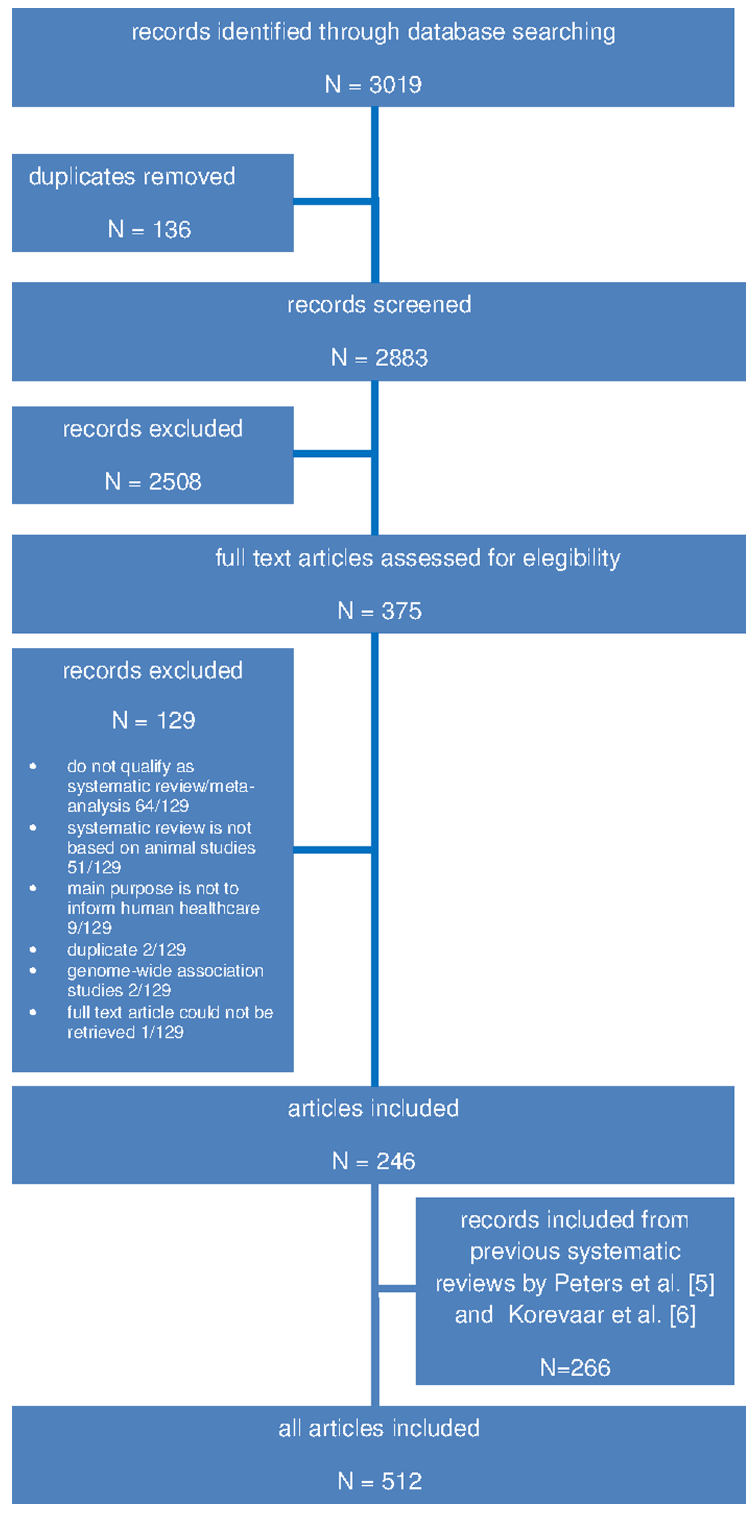
Fig. 1. Flow chart for selection of systematic reviews included in the systematic review.